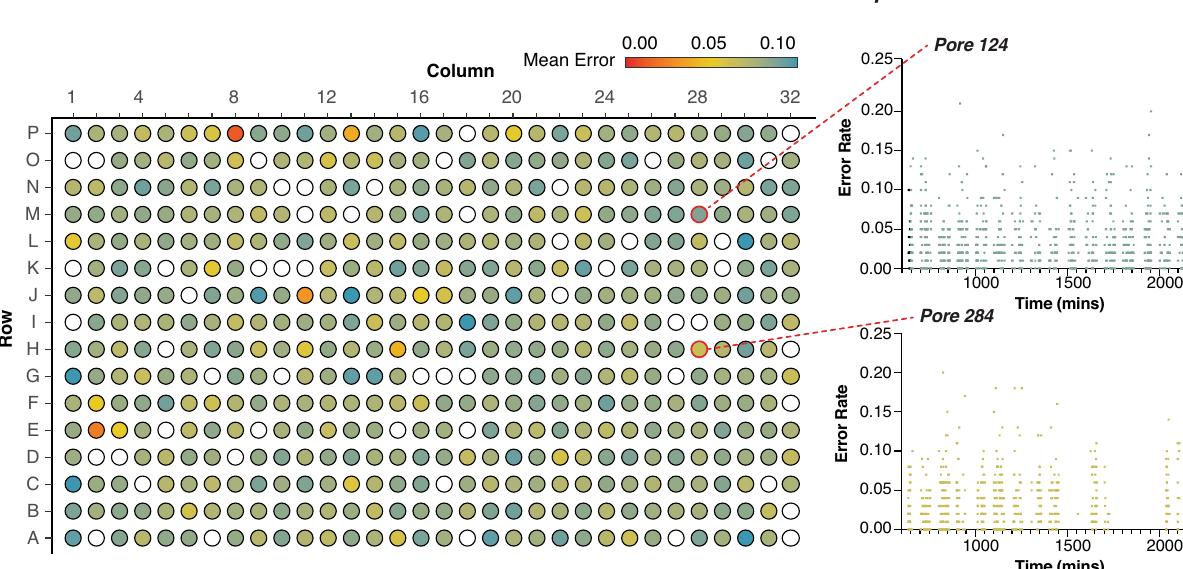
Fig.2|MeasuringsequencingaccuracyusingCAPTORs.a Scatterplotshowsthe mismatchandindelsequencingerrorpro fi lesfor6-mers(rankedbytotalerrorrate) inCAPTORsfromasingle library. b Scatterplotshowsthesequencing errorpro fi les for 6-mers (ranked by mean error rate) in replicate libraries ( n =3). c Schematic